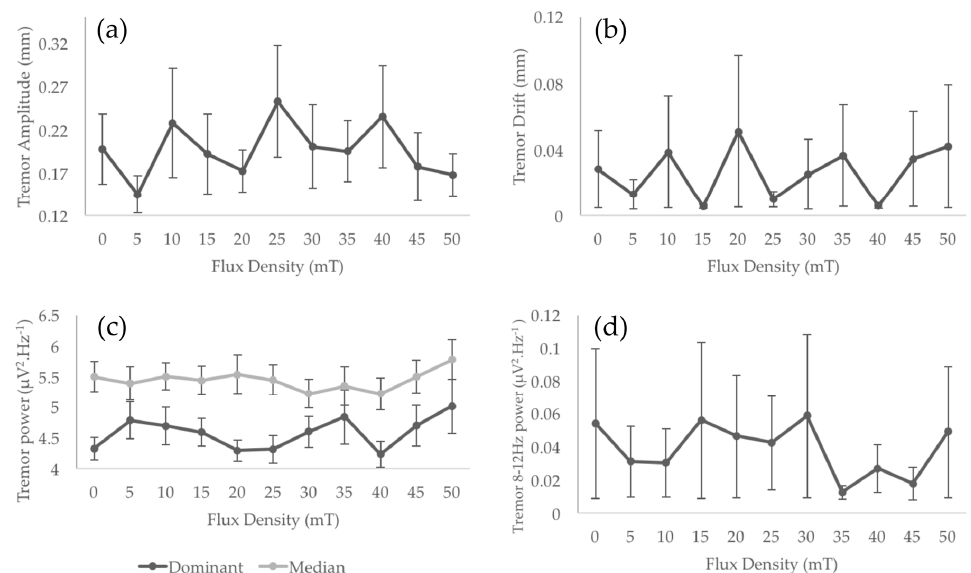
Figure 4. All Tremor characteristics: Tremor amplitude ( a ); tremor drift ( b ); dominant and median frequency spectral power ( c ); and tremor 8–12 Hz spectral power ( d ). None of these characteristics showed significant change with increase in flux density. The four panels represent average values calculated on the ten participants for each MF exposure condition (from 0 to 50 mT rms ). Error bars at each data point represent standard error of the mean. Int. J. Environ. Res. Public Health 2017 , 14 , 1446